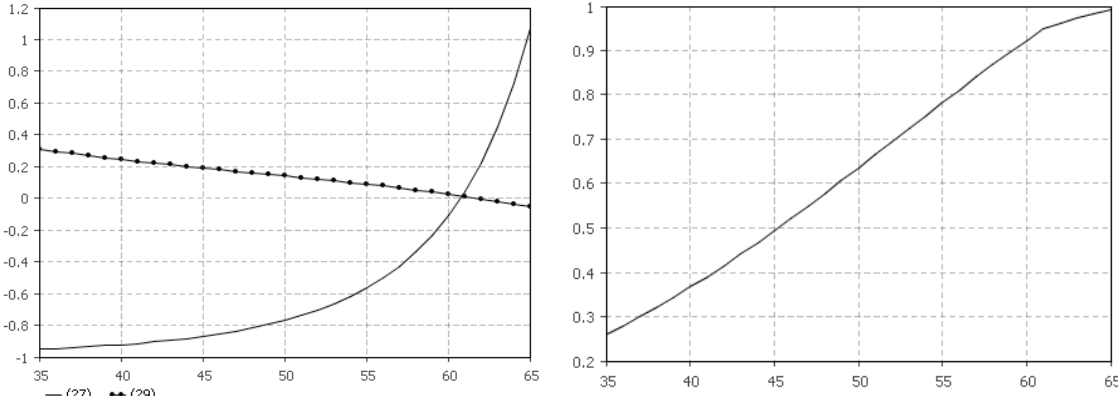
Figure 7. Finding the f switching point of control problem (Option B)